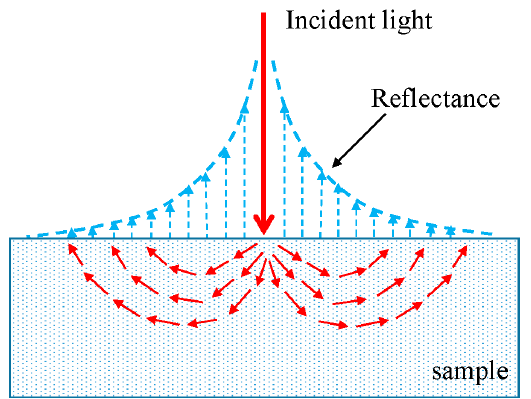
Figure 1. Spatially resolved spectra at different source-detector distances.